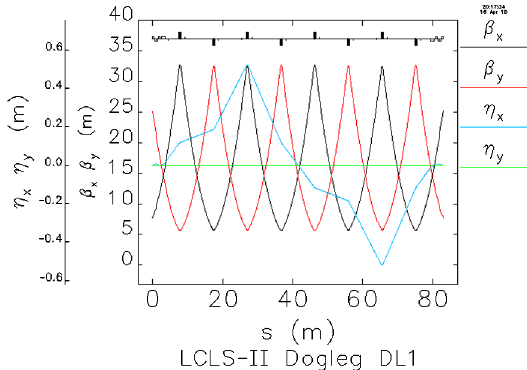
FIG. 2. Lattice functions (evaluated with ELEGANT [18]) along the achromatic dogleg DL1, presently under consideration for LCLS-II and used in our example illustrating TSC-induced longitudinal microbunching. At both extremities of the beam line two small four-bend chicanes provide local compensation of the linear momentum compaction R 56